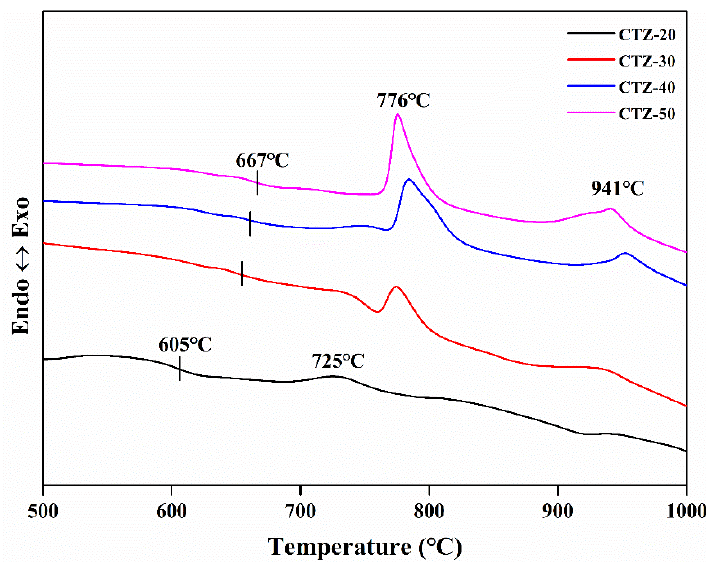
Figure 2. DTA curves of the glass with different CTZ content.